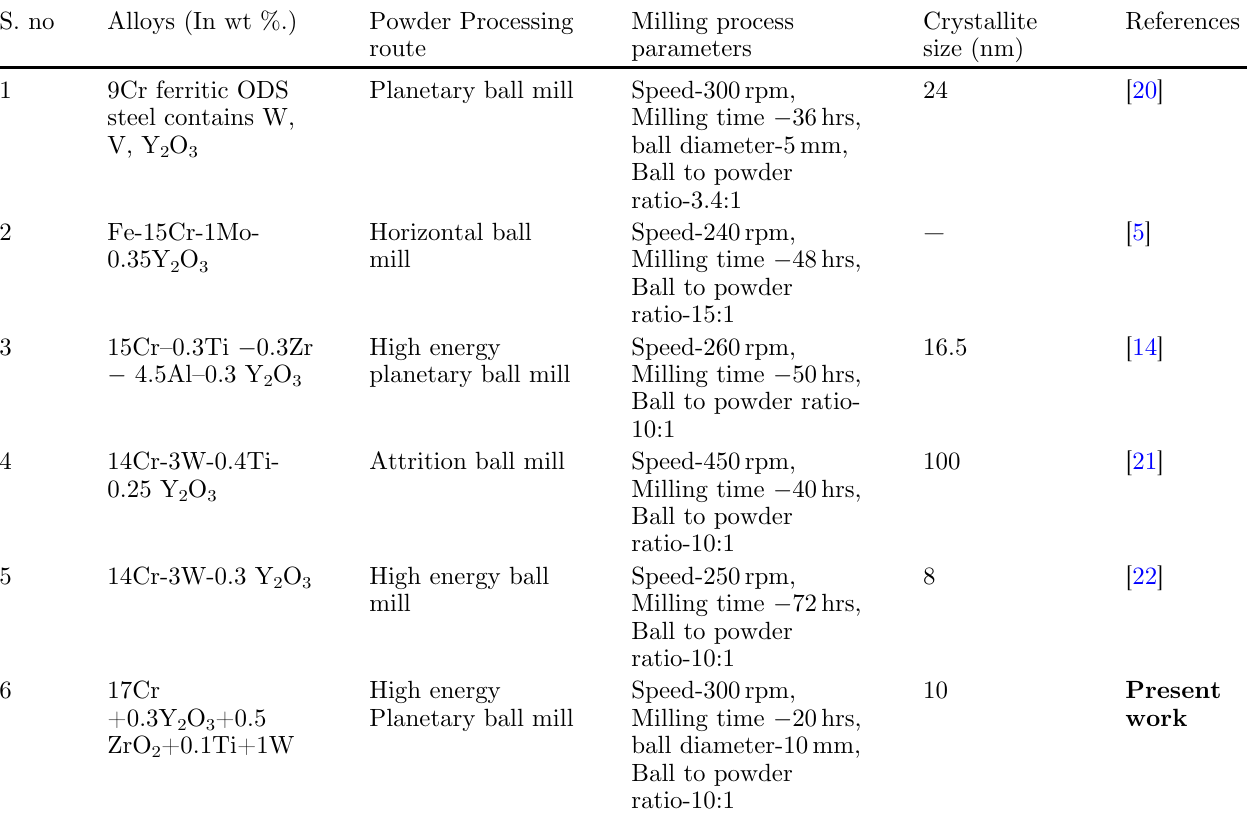
Table 7. Comparison of milling process parameters than existing processing of the alloys. S. no Alloys (In wt